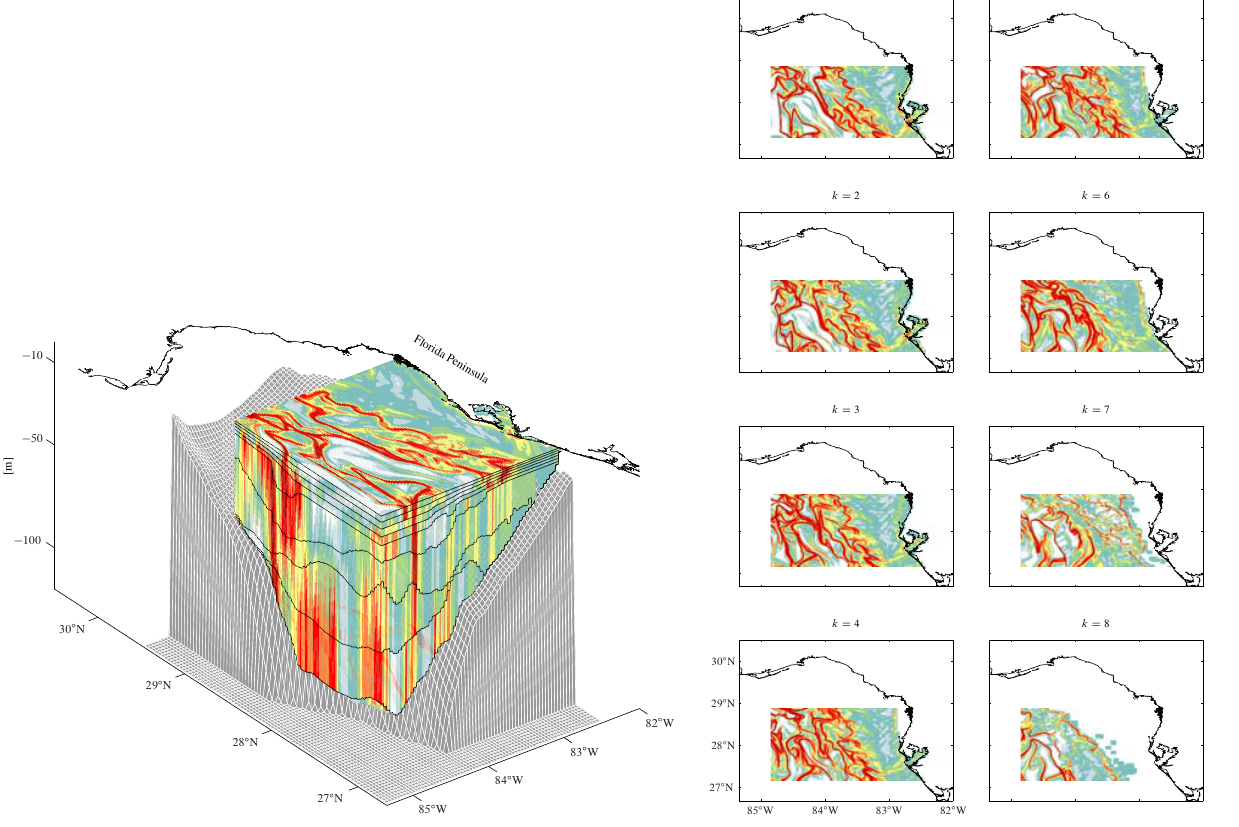
Fig. 4. Left panel: asnapshot on 10 July 2010 showing backward-time FTLEs in three-space dimensions in a domain including a portion of the WFS and extending to the shelfbreak (the bottom topography is indicated in grey). Right panels: two-dimensional FTLE fields on the surface layer ( k = 1) and several subsurface layers ( k = 1 ,..., 8) used to construct the three-dimensional plot in the left panel.